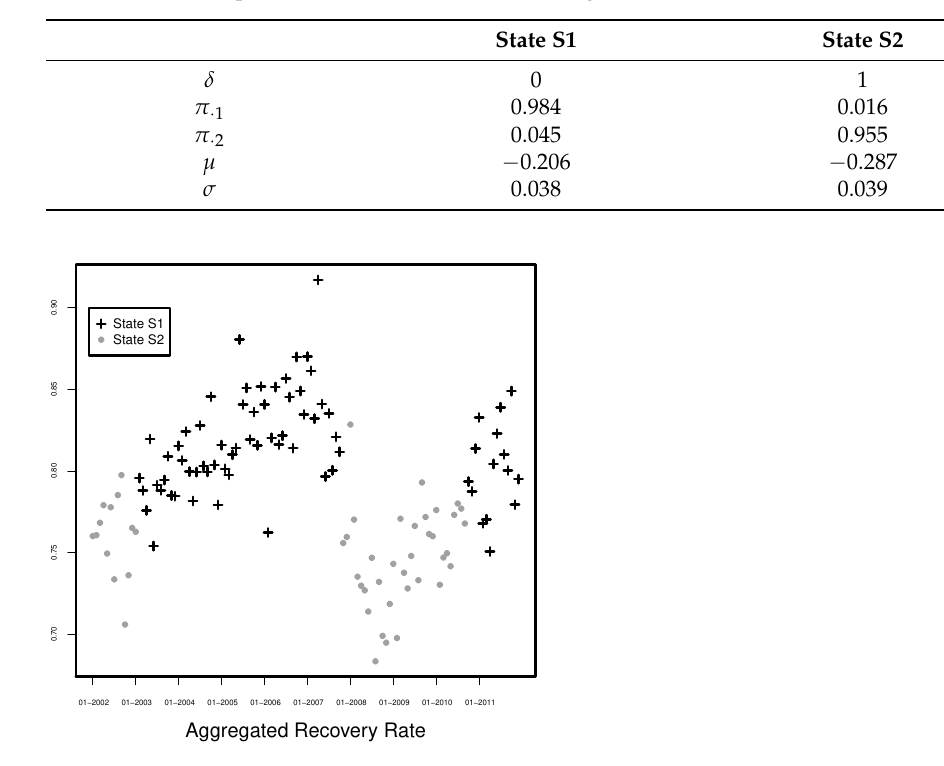
Figure 19. States sequence of the Markov